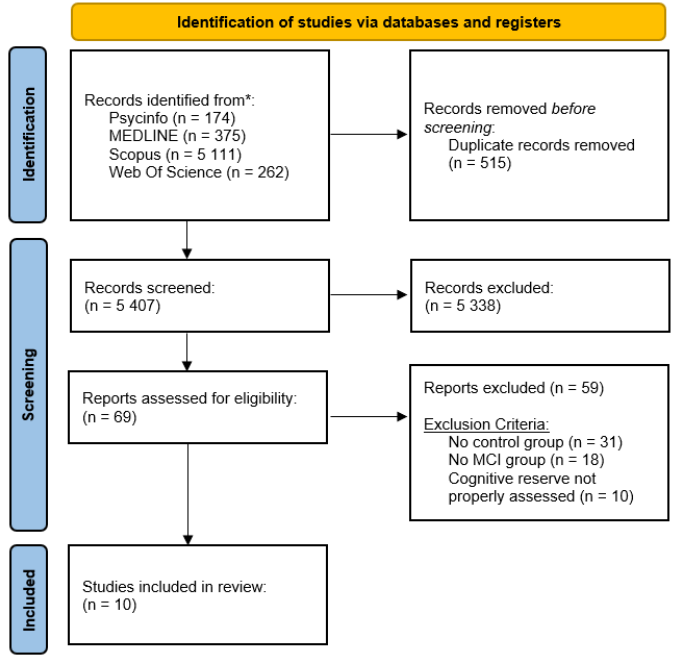
Figure 1. PRISMA 2020 Flow Chart.